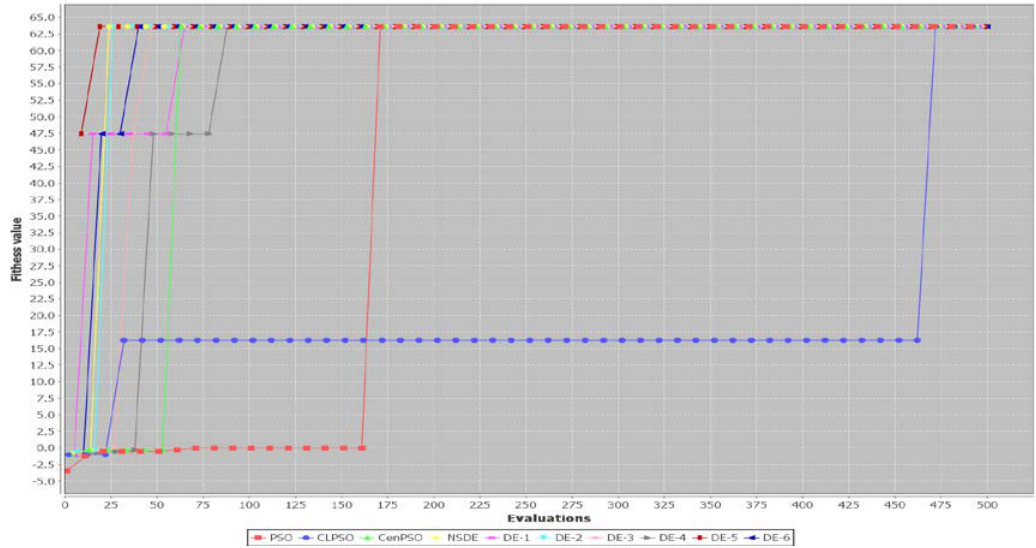
Figure A2. Convergence speed of a run of each algorithm for Case 2 with POP = 30.